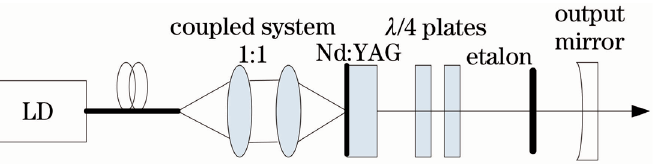
Figure 6. Diagram of the tunable two-frequency solid-state laser with coupled cavities [22]. LD: laser diode; λ /4 plate: quarter-wave plate.